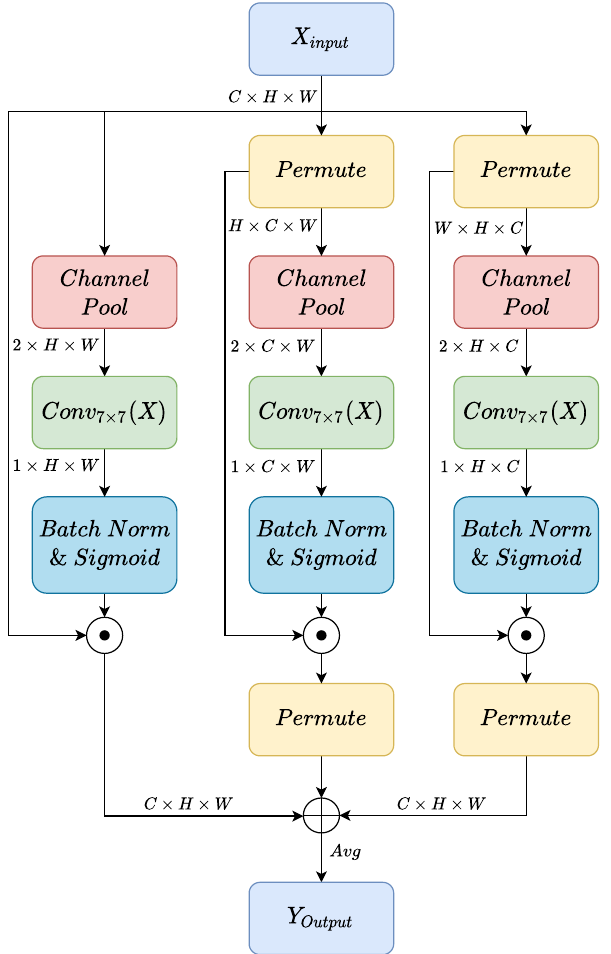
Figure 5. Demostration of the structure of triplet